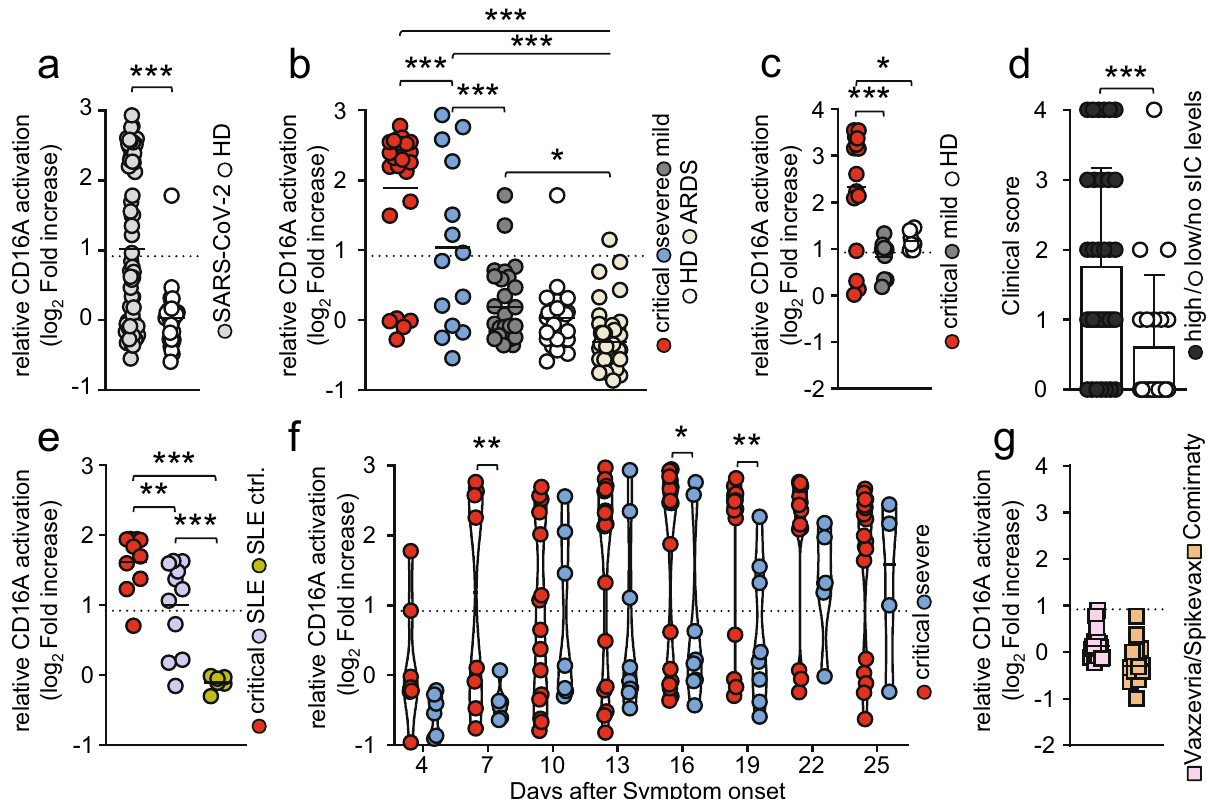
Fig.4|SevereCOVID-19diseasecoincideswithhighFc γ RIIIA/CD16Aactivation